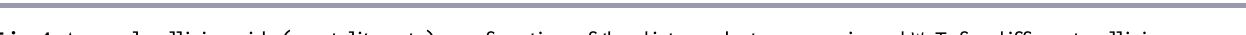
Fig. 4. Annual collision risk (mortality rate) as a function of the distance between aerie and WT for different collision avoidance probabilities. Panel (a) is obtained for strategy (pf = 0.3 and T = 3.6 min)_with pBAND = 0.144, panel (b) for strategy (pf = 0.4, T = 12 min) with pBAND = 0.144, panel (c) for strategy (pf = 0.3 and T = 3.6 min) with pBAND = 0.205, and panel (d) for strategy (pf = 0.4, T = 12 min) with pBAND =